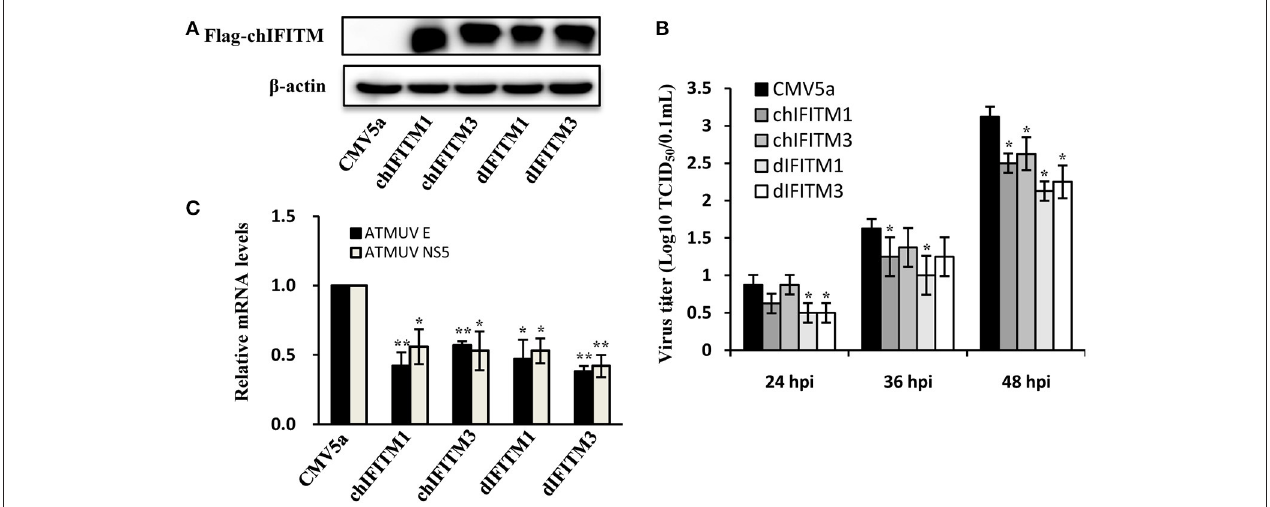
FIGURE 6 | Overexpression of chicken or duck IFITM1 and IFITM3 restricts ATMUV infection in vitro . DF-1 cells stably expressing chicken or duck IFITM1, 3, or empty vector were infected with ATMUV at a MOI of 1.0 and harvested at indicated time points (24, 36, and 48 hpi). (A) The forced expression of IFITMs in DF-1 cells was examined by Western blotting using an anti-flag antibody at 36 hpi. (B) The viral titers in cell culture supernatants were determined by TCID 50 assay in DEF cells. (C) The mRNA expression of viral genes was examined by qRT-PCR at 36 hpi. The mRNA levels were normalized to the endogenous β -actin level and the expression in ATMUV infected DF-1 cells expressing empty vector was set to 1.0. The mRNA expression of viral genes in DF-1 cells expressing exogenous IFITMs was compared to that in control cells containing empty vector. Plotted are the average results from three independent experiments (means ± SD ). Statistical significance was determined by one tail Student’s t -test analysis. * P < 0.05, ** P <